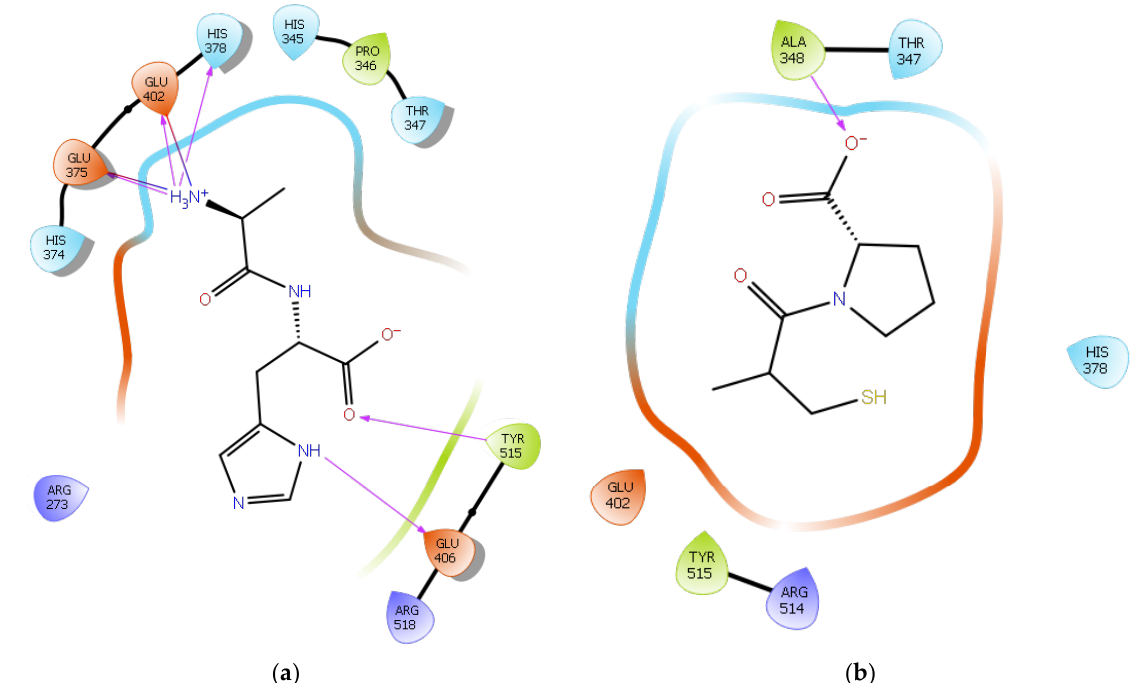
Figure 2. ( a ) Docking results of the peptide Carnosine in the human angiotensin-converting enzyme 2 (ACE2) active site. The interactions of human ACE2 residues with Carnosine (represented in black) are indicated by arrows of different colors, with purple representing hydrogen bond interactions and blue arrows representing salt bridge interactions. ( b ) Docking results of the synthetic drug Captopril in the human angiotensin-converting enzyme 2 (ACE2) active site. The interaction of human ACE2 residues with Captopril (represented in black) is indicated by a purple arrow representing hydrogen bond interactions.